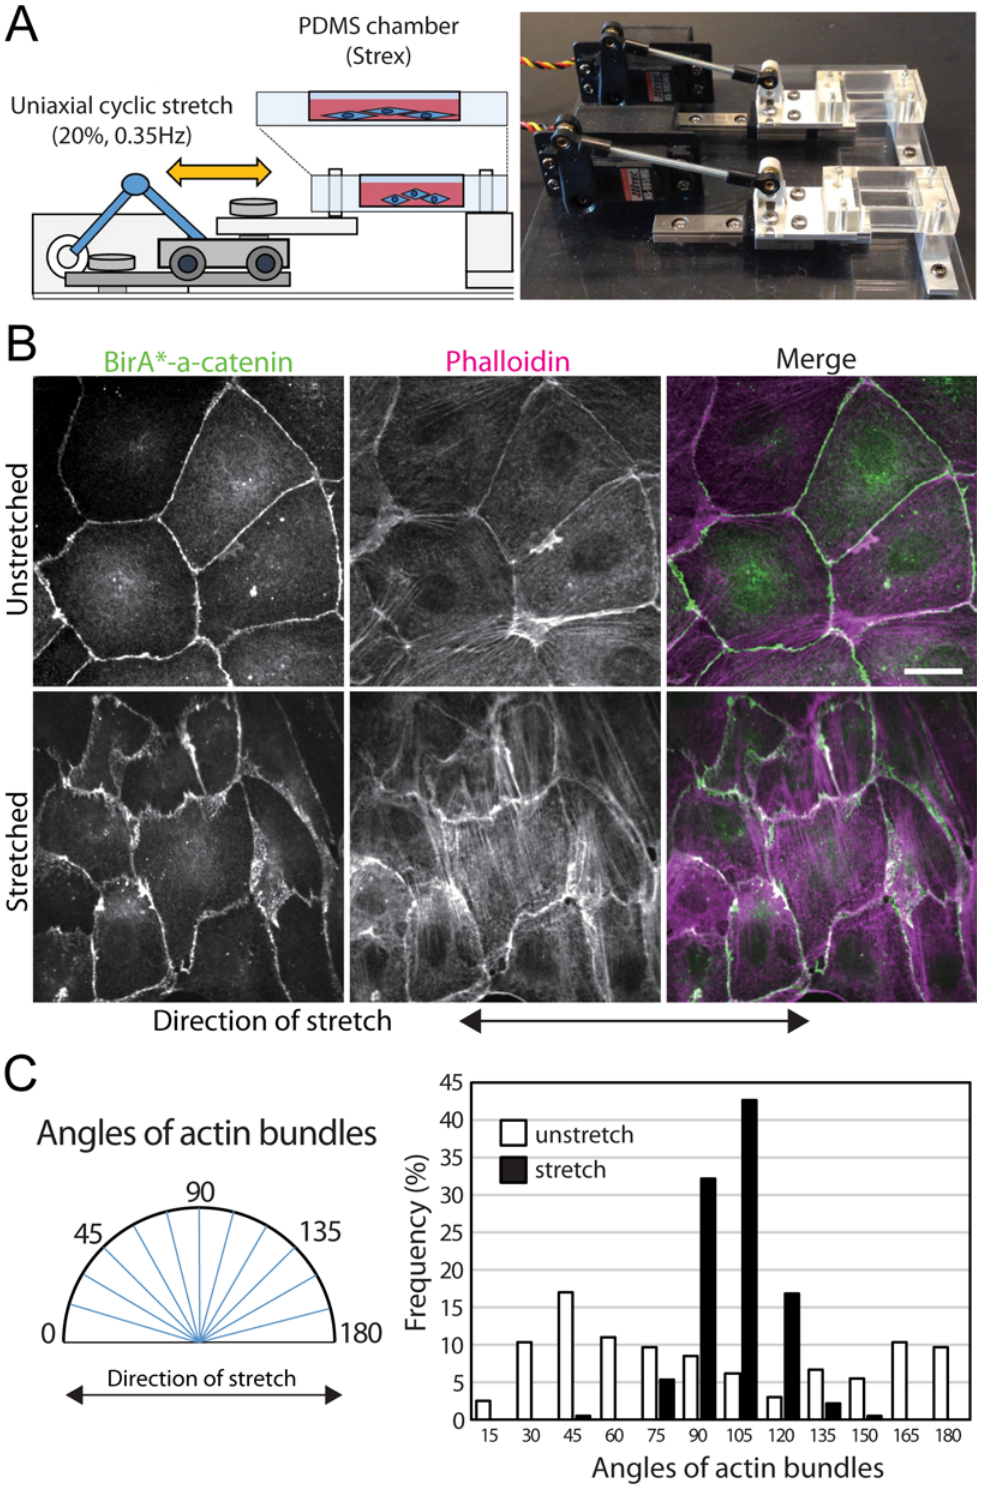
Fig 3. Cyclic stretch induces re-organization of actin fibers. (A) Schematic of the substrate stretch device and an image of the actual device used in this study. The adherent cells in the PDMS cell chamber (STREX) were stretched by a servo motor coupled to the chamber via mechanical linkages. (B)